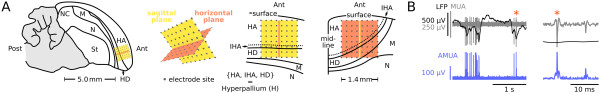
High-density recording methods. (A) Location of the 64-channel silicon multi-electrode probe. An 8 × 8 electrode grid with 200 μm inter-site spacing extends over a 1,400 × 1,400 μm plane in the hyperpallium. Probes were inserted horizontally (red plane) or sagitally (yellow plane). The horizontal plane is orthogonal to the sagittal plane and is shown as a thin line in the sagittal brain section. The orientation of horizontal electrode grids is always depicted so that the medial side is on the left and the anterior side (that is, brain surface) is on top; sagittal grids are depicted so that the caudal side is on the left and the anterior side (that is, brain surface) is on top. Together, horizontal and sagittal recordings provide insight into the three-dimensional spatial extent of activity propagation patterns. Thalamic input to the hyperpallium (H), which is where most recordings were performed (n = 11 birds), terminates primarily in the interstitial part of hyperpallium apicale (IHA), a thin region underlying the rest of hyperpallium apicale (HA) and overlying the hyperpallium densocellulare (HD). Output projections from the HA course medially over the surface of the brain before descending down the septomesencephalic tract. The hyperpallium overlies and is interconnected with the mesopallium (M) and nidopallium (N), large nuclear structures composed of similar stellate neurons, involved in high-order cognitive processes comparable to those performed by the neocortex
[26]. Two additional recordings were performed in caudal nidopallium (NC; n = 2 birds). (B) Raw intracerebral signals were recorded and off-line filtered to a signal containing local field potentials (LFP, 0.1 to 350 Hz), and to a signal containing multiunit action potentials (MUA, 0.5 to 5 kHz). To obtain a signal that corresponds to the level of multiunit action potential firing, the MUA signal was rectified and decimated (analogue multiunit activity, AMUA).